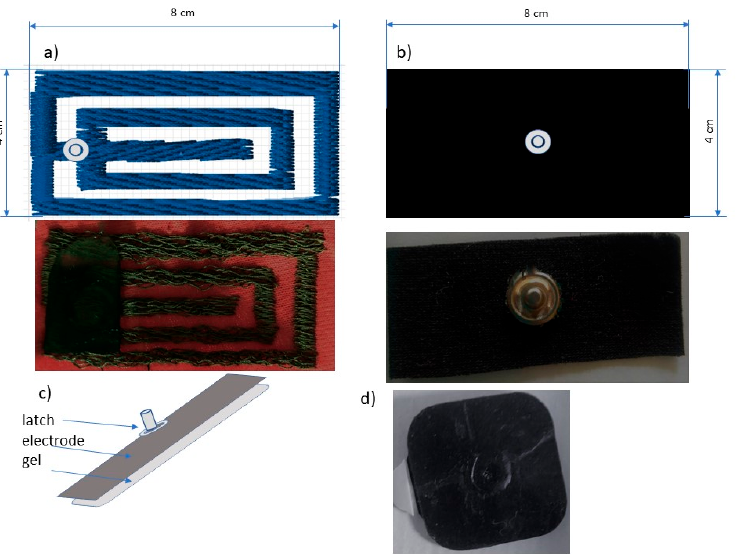
Figure 2. Pattern of electrode made by ( a ) machine embroidery technique, ( b ) film printing, ( c ) electrode cross-section, and ( d ) commercial electrode. Commercial electrodes with a silver-plated layer on a nonwoven gel-layer were used as reference electrodes.